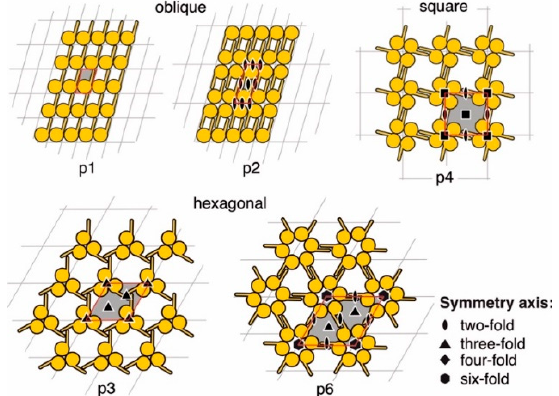
Figure 6. Schematic drawing of the five different S-layer lattice types with their symmetry axes. Unit cells are marked in grey and outlined in red (reproduced with permission from Reference [4]; published by Oxford University Press, 2014).